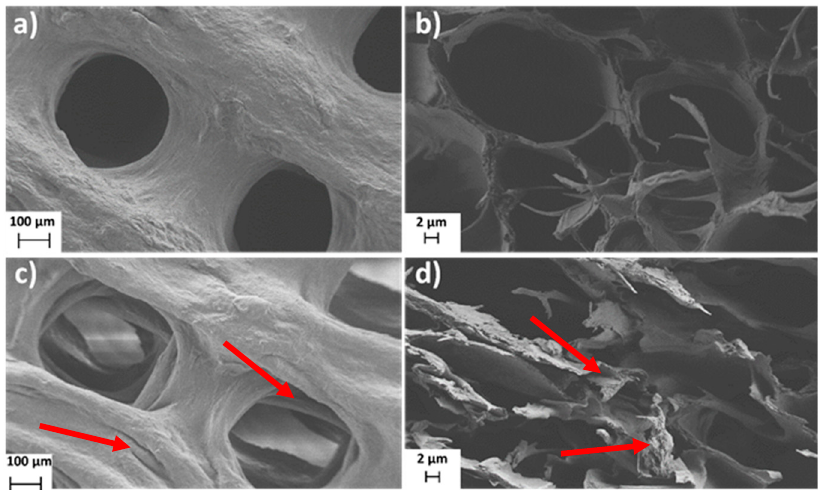
Figure 3. FE-SEM images of AISI 316LVM ( a , b ) and AISI 316LVM – CLIN ( c , d ). Microphotographs were taken at different magnifications and from different views (( a , c )—top view, ( b , d )—side view). Red arrows show the additional morphological features (e.g., furrows) on the surface of the CLIN- loaded samples.